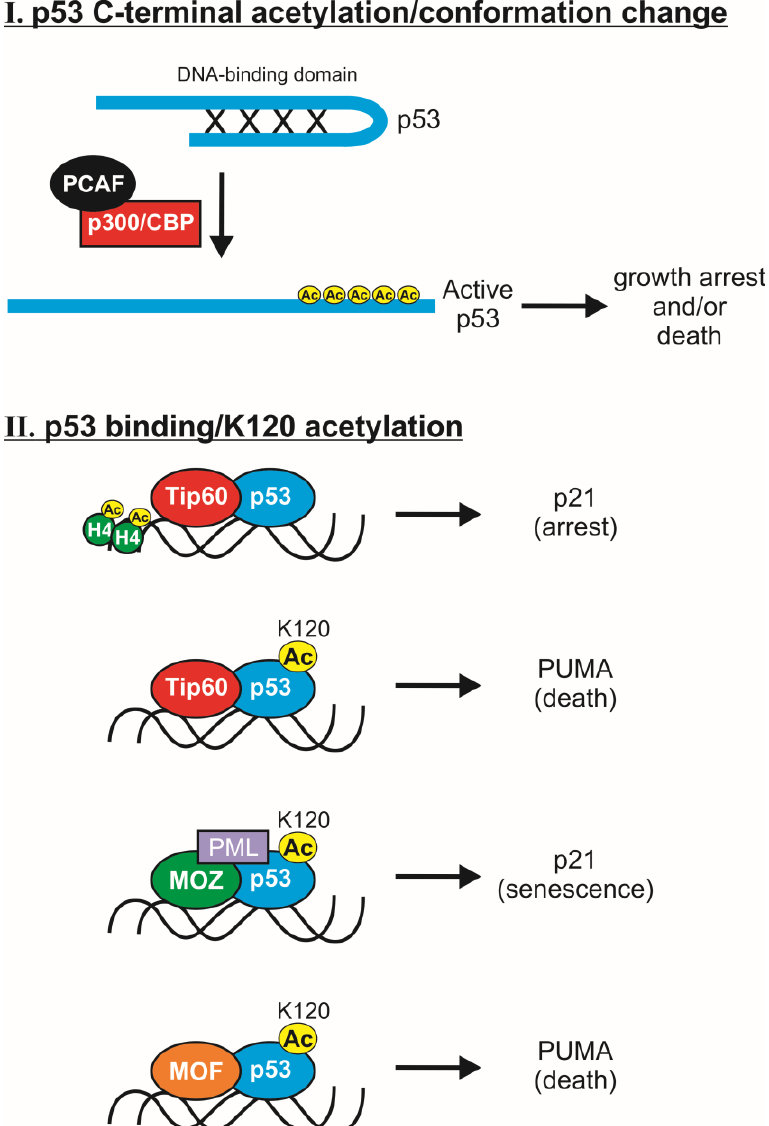
Figure 4. Acetylation-dependent mechanisms of p53 activation. Two primary mechanisms exist by which p53 function is enhanced by its acetyltransferases. ( I ) C-terminal acetylation of p53 by p300/CBP and PCAF promotes an open conformation of p53 by preventing the occlusion of the DNA binding domain by the C-terminal tail. This enhances p53 transcriptional activity, leading to growth arrest and/or apoptosis; ( II ) Interactions of MYST HATs with the central domain of p53 containing K120. Tip60 is an essential component of p53 signaling that activates p53 through direct association on target promoters as well as acetylation of p53 at K120. p21 expression is induced by Tip60-p53 complexes that bind to and promote histone H4 acetylation at the p21 promoter, which leads to a potent growth arrest. K120 acetylation mediated by Tip60 and MOF selectively increases p53 binding to apoptotic gene promoters, thus inducing cell death. Unlike Tip60 and MOF, MOZ-mediated K120 acetylation of p53 specifically induces senescence by promoting transactivation of the p21 promoter. For simplicity, other concomitant p53 acetylation events and association with p300/CBP and/or PCAF are not